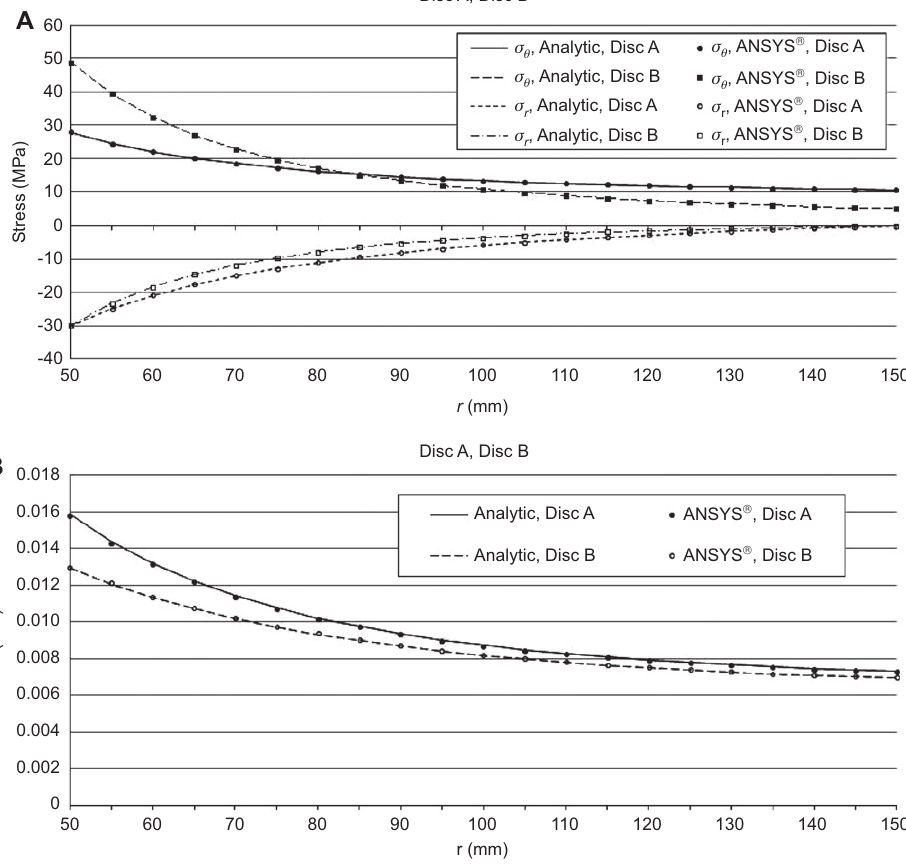
Figure 4 Variations of (A) tangential and radial stresses and (B) radial displacements at Disc A and B with internal pressure of 30